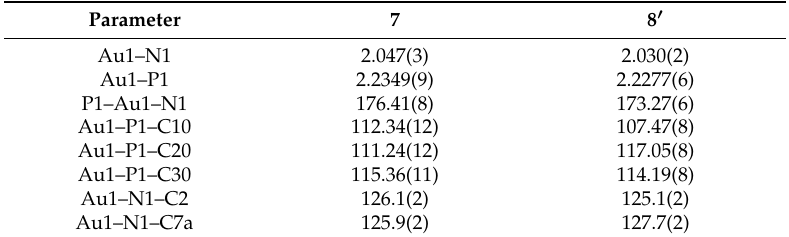
Table 2. Selected bond lengths (Å) and angles (°) for the complexes [Au( 3I5Br aza)(PPh 3 )] ( 7 ) and